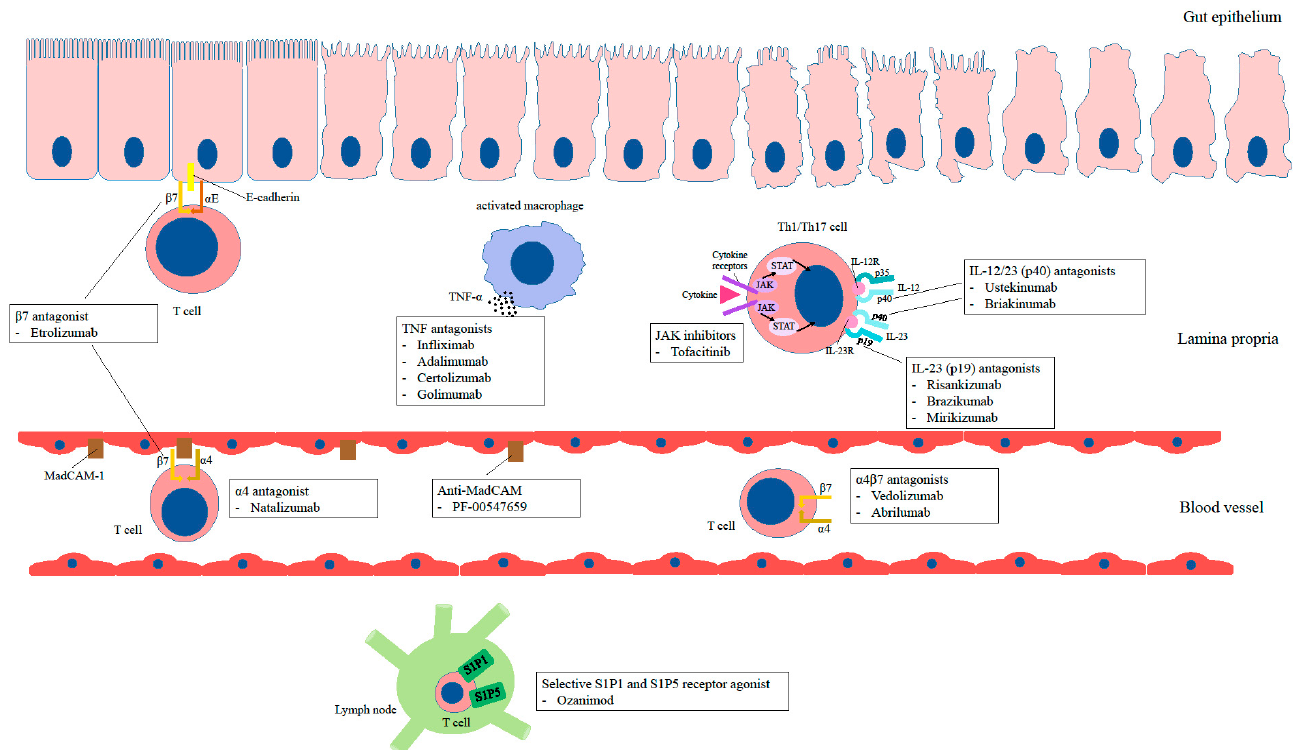
Figure 2. Effect of biological drugs on the modulation of the immune response in patients with inflammatory bowel diseases. TNF—tumor necrosis factor, JAK—Janus kinase, MadCam-1—Mucosal vascular addressin cell adhesion molecule 1, S1P1—Sphingosine ‐ 1 ‐ phosphate receptor 1, S1P5— Sphingosine ‐ 1 ‐ phosphate receptor 5.